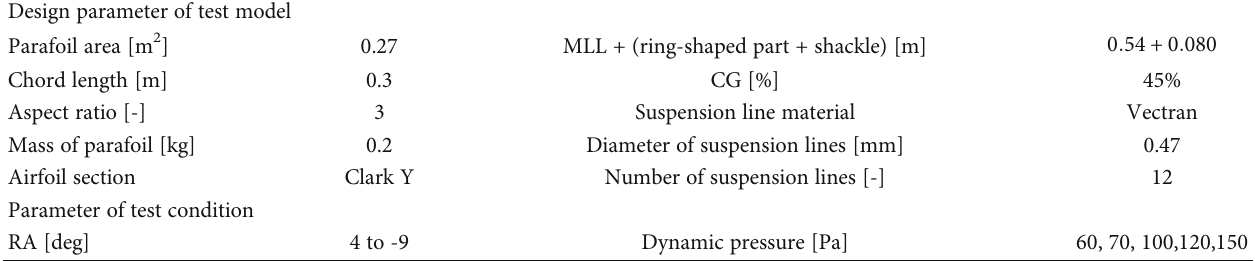
Table 3: Design parameter of test model and test condition of wind tunnel test.